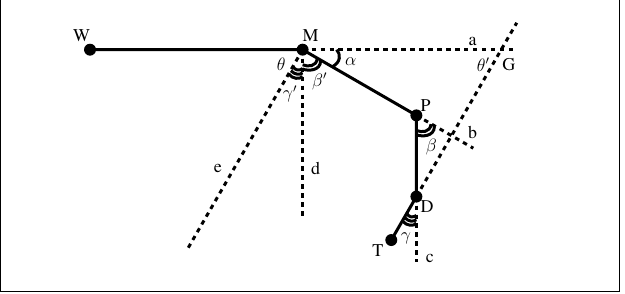
Figure 5. Geometry model of the